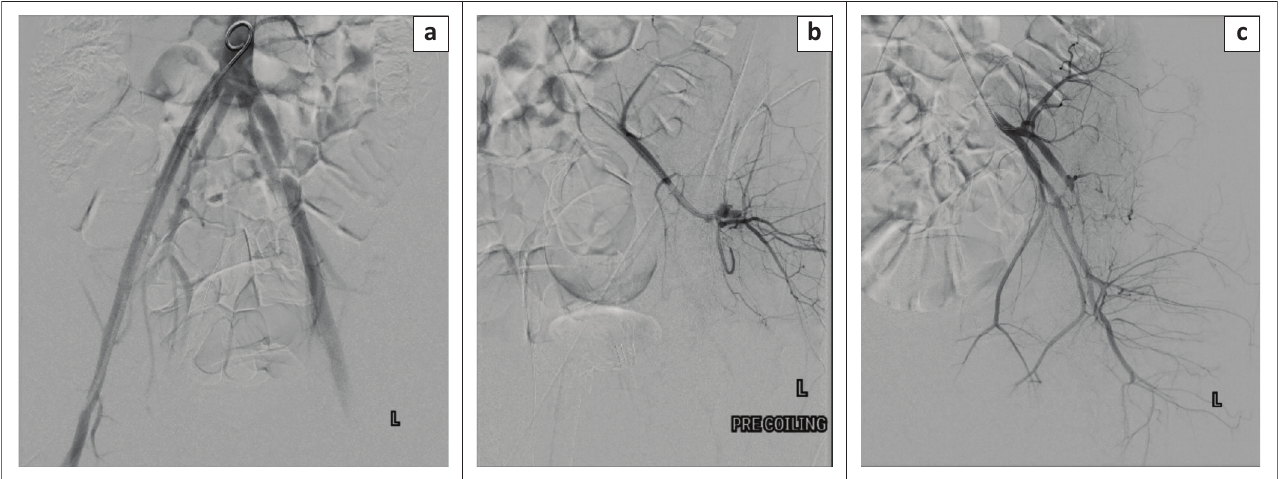
FIGURE 2: (a) Digital subtraction angiogram of the terminal aorta demonstrates bilateral absence of the common iliac arteries. (b) Digital subtraction angiogram of the posterior division of the left internal iliac artery demonstrating the traumatic pseudoaneurysm of the superior gluteal artery. (c) Digital subtraction angiogram of the left internal iliac artery demonstrated successful post-embolisation exclusion of the